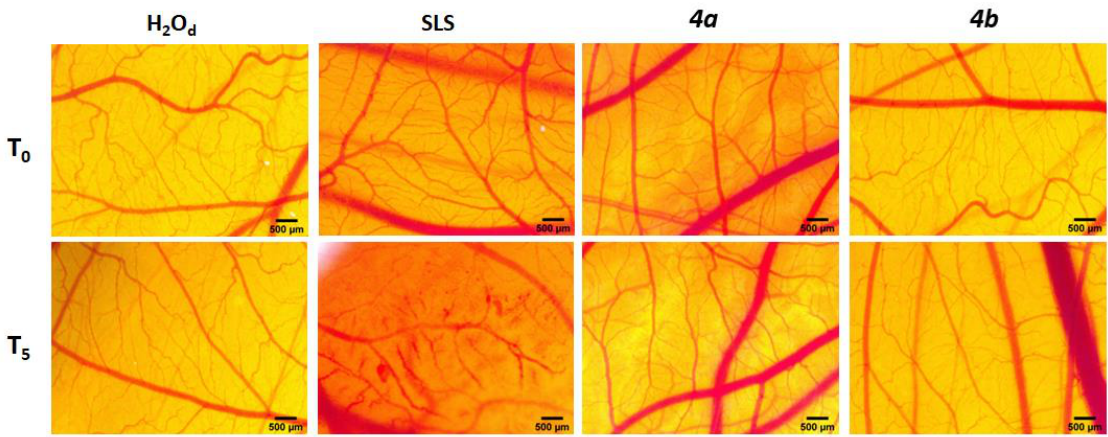
Figure 9. The irritation assessment using the HET − CAM method. Stereomicroscope images of the chorioallantoic membrane were taken before (T 0 ) and 300 s (T 5 ) after treatment with 300 µ L compounds 4a and 4b, respectively (tested at IC 50 : 18.8 µ M and IC 50 : 20.7 µ M); distilled water was used as negative control while SLS 0.5% acted as positive control). Scale bars represent 500 μm.